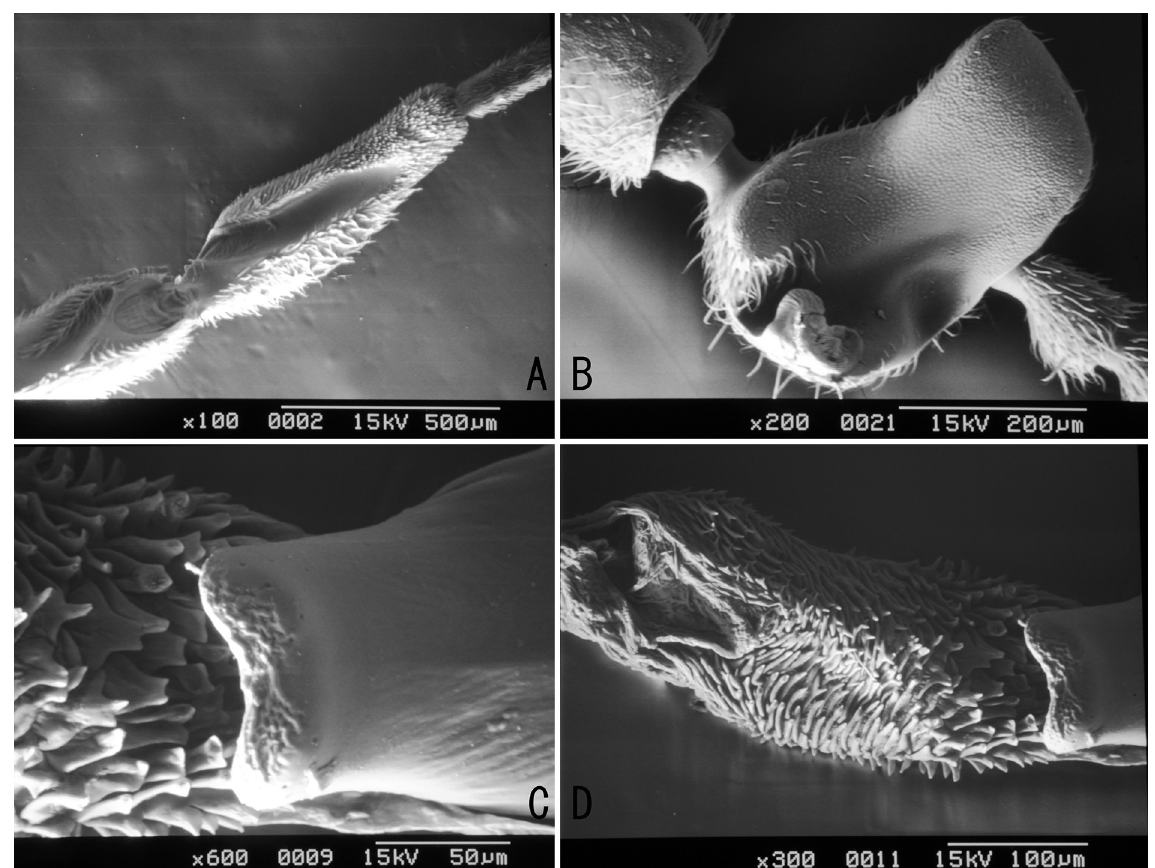
Fig. 12. Laius andamanensis sp. nov., ♂, paratype. A . Inner part of fore leg, showing enlarged femur and tibia. B . Antennomere III. C . Aedeagal apex. D . Spinous area (SEM